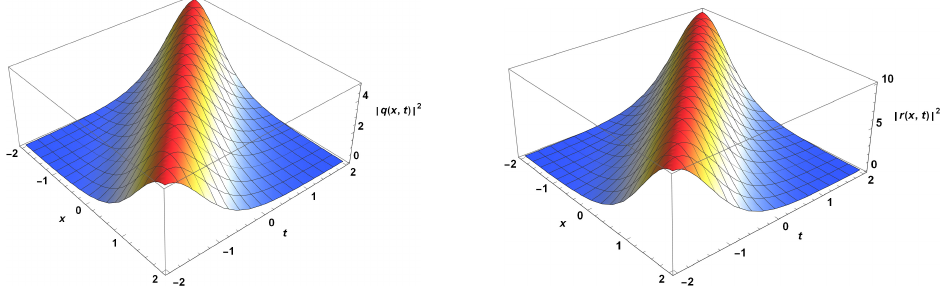
Figure 2. Profiles of bright solitons in birefringent